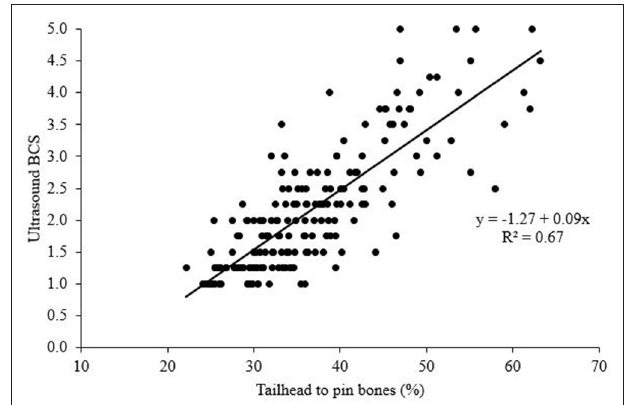
FIGURE 4 | Relationship between the tail head to pin bones width and ultrasound body condition score (BCS).